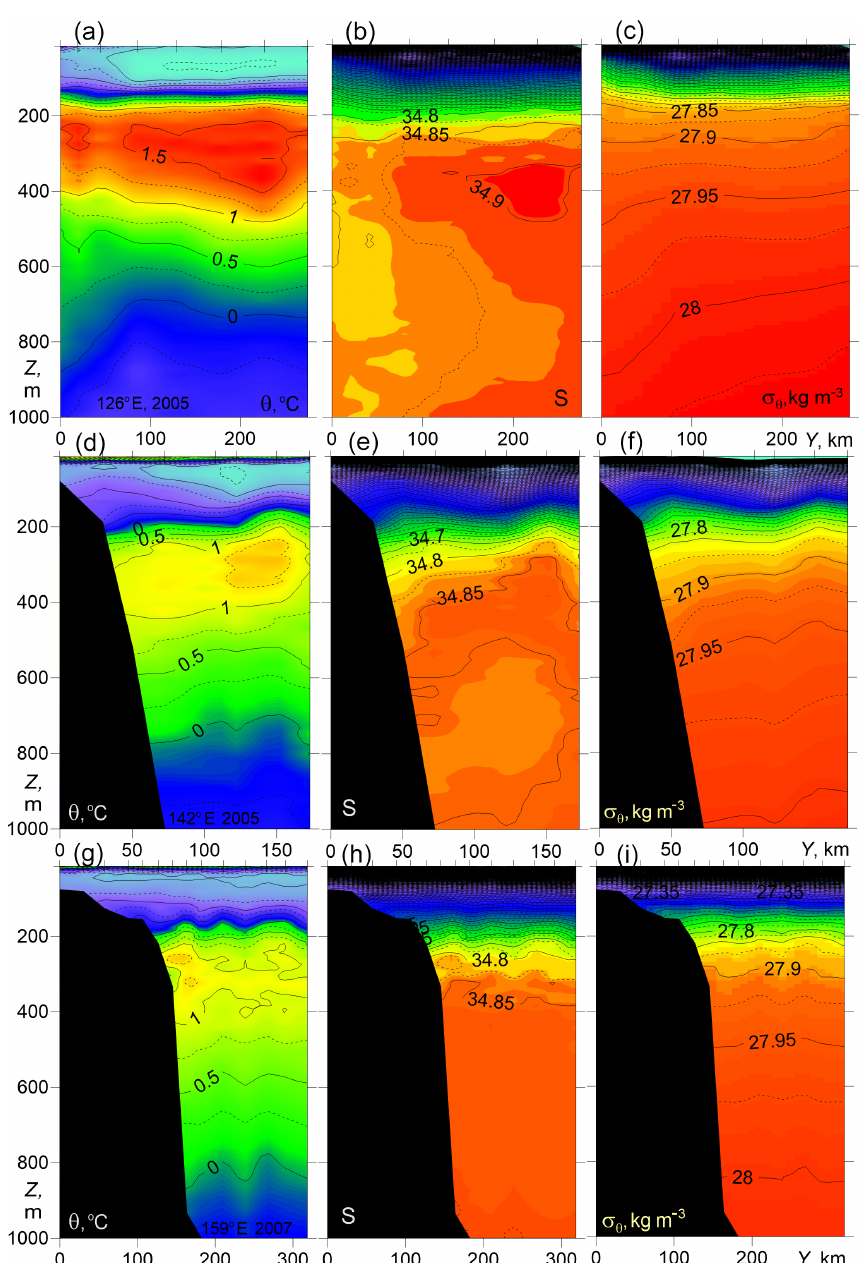
Figure 6. Temperature θ , salinity S , and potential density anomaly σ θ vs. distance and depth for cross-shelf transects at 126, 142 ◦ E ( a–c and d–f , NABOS05) and 159 ◦ E ( g–i ,